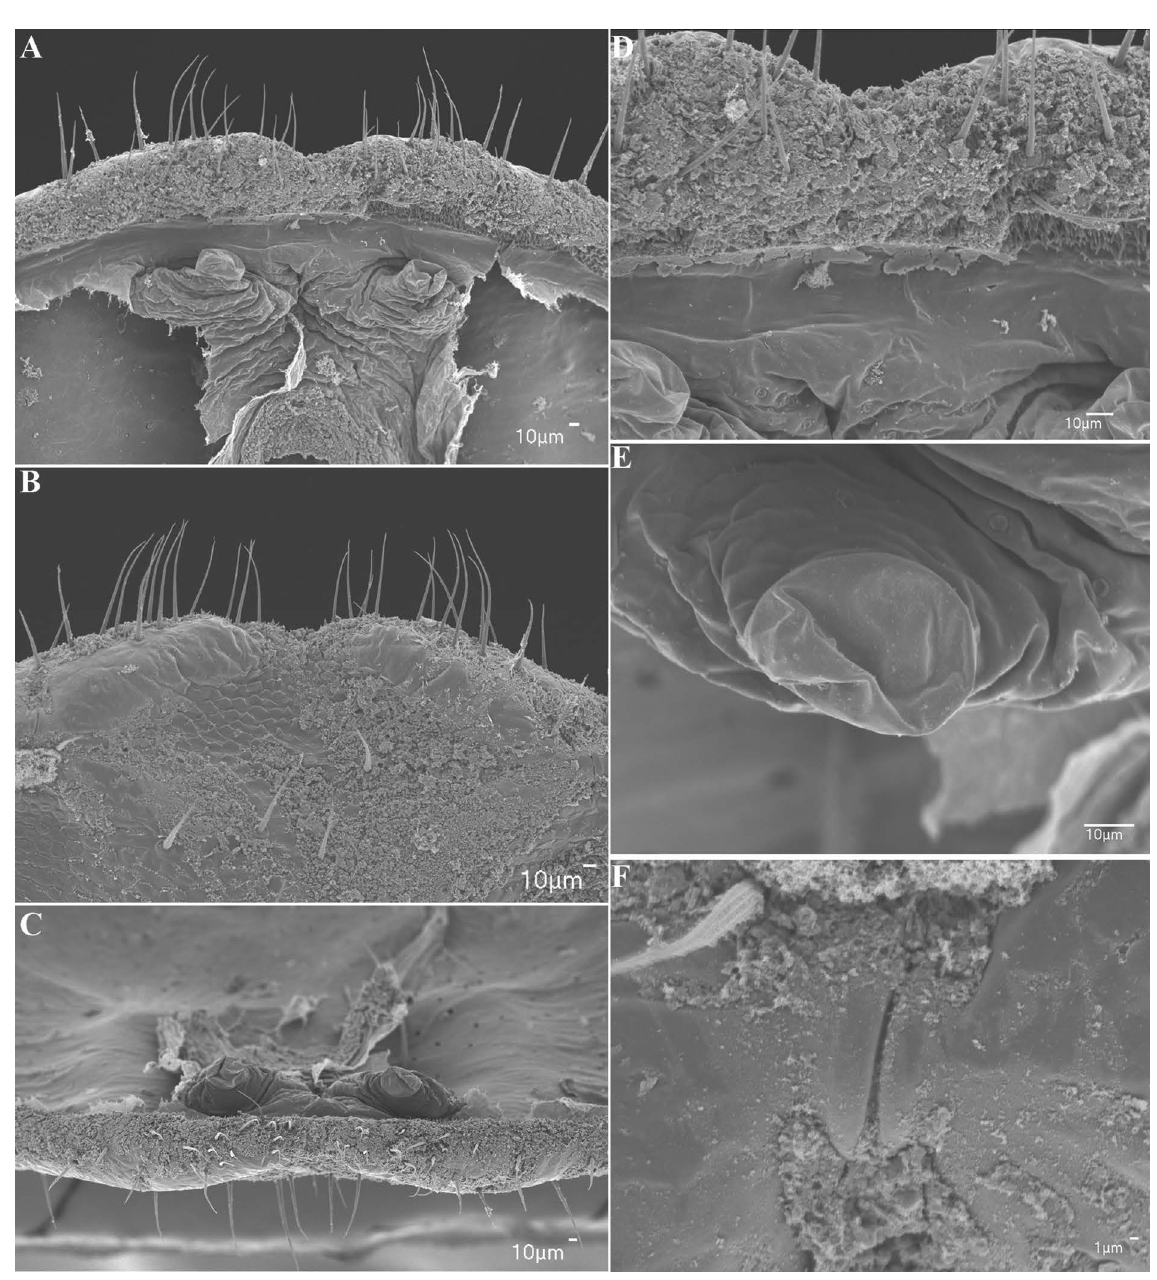
Fig. 111. Sarax gravelyi sp. nov. (AMCC [11995]), female gonopod and genital operculum. A . Finger- like gonopod, dorsal view. B . Posterior margin of genital operculum, ventral view. C . Gonopods, posterior view. D . Genital operculum between gonopods. E . Dextral gonopod. F . Glandular opening on margin of